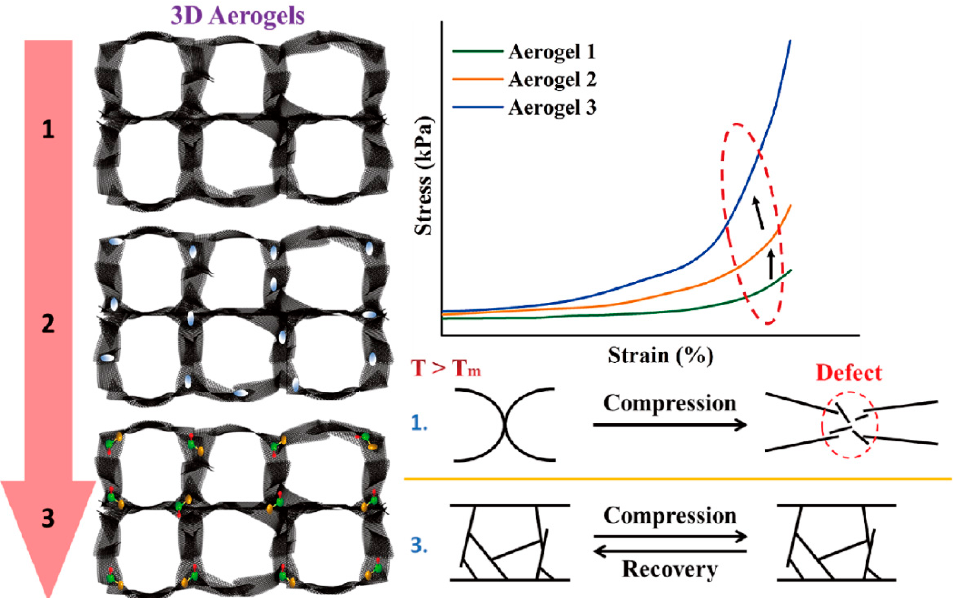
Figure 9. Schematic of the 3D porous graphene aerogels with different internal structures. The cross-linked graphene aerogel has the best mechanical properties to reduce the volume shrinkage effectively. The final PCM composite can sustain the initial solid state without any damage under the external force at a high temperature.